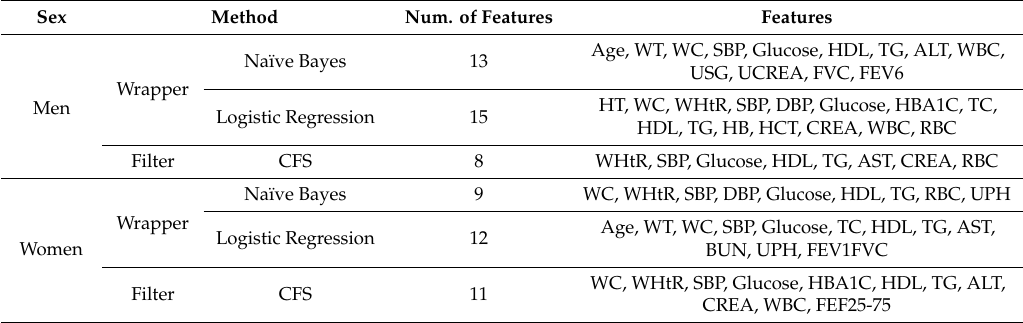
Table 5. Feature selection using the wrapper and filter method for each model.